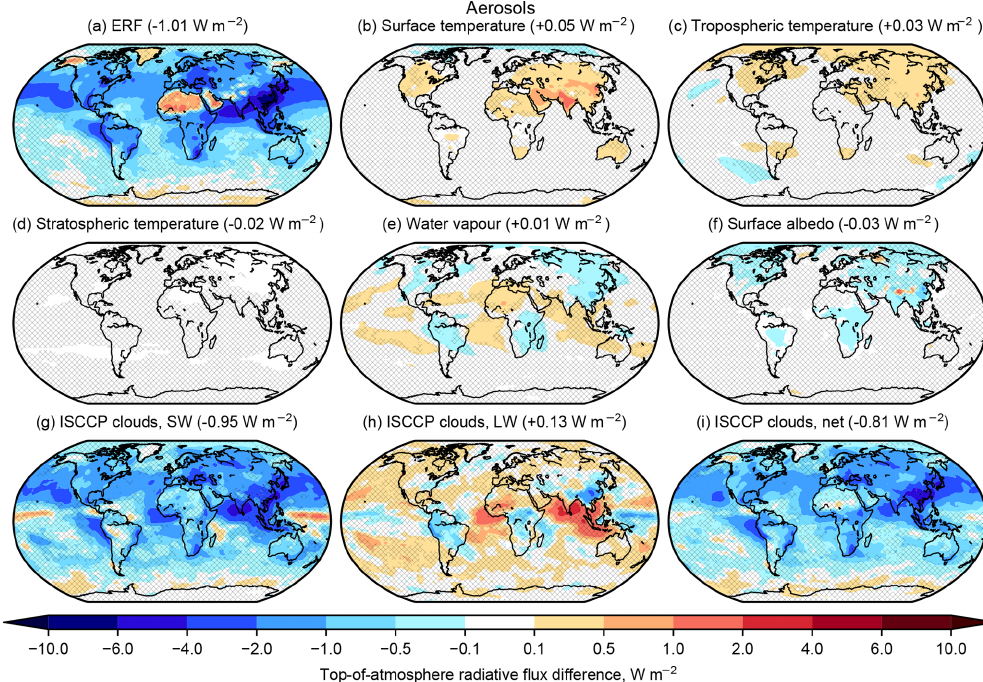
Figure 8. As Fig. 6 but for present-day aerosol forcing.